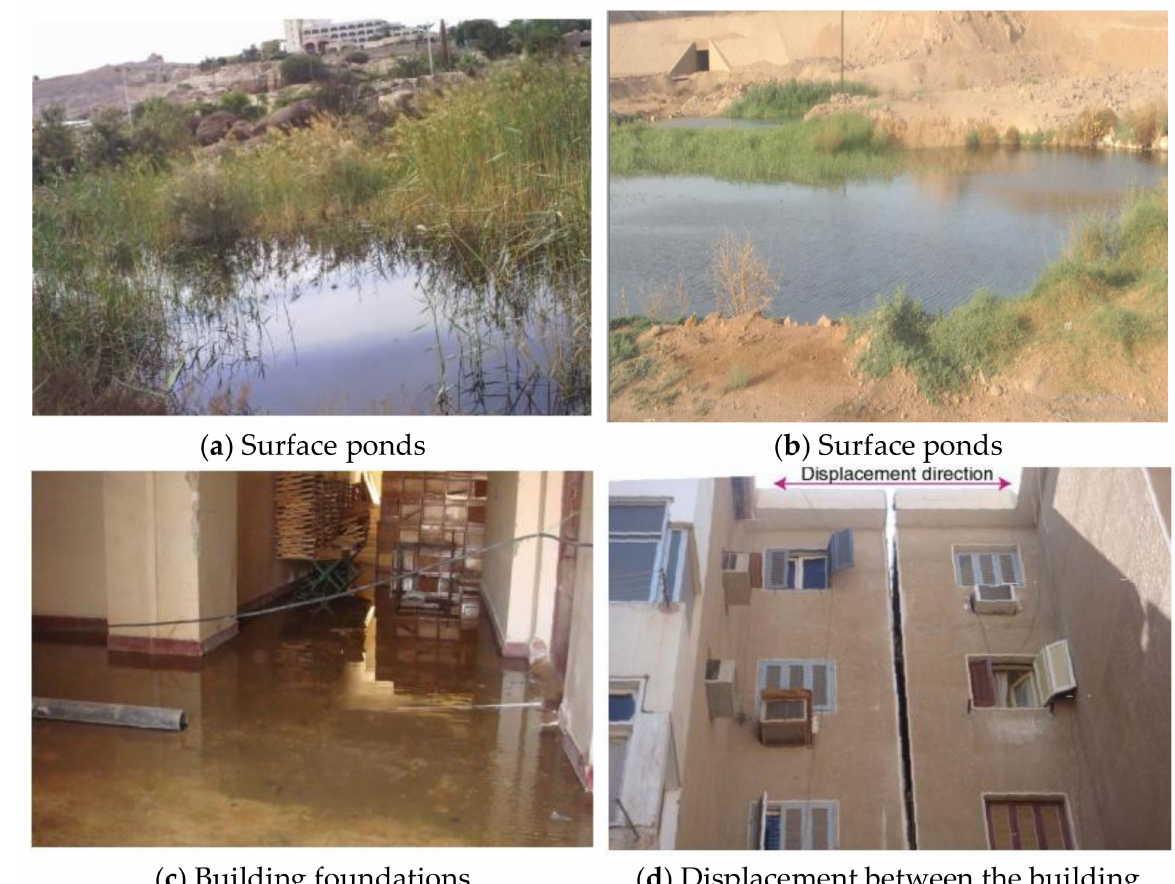
Figure 1. The effects of groundwater on the study area; ( a , b ) Formation surface ponds; ( c ) Flooding the foundations of buildings; ( d ) The appearance of displacement between